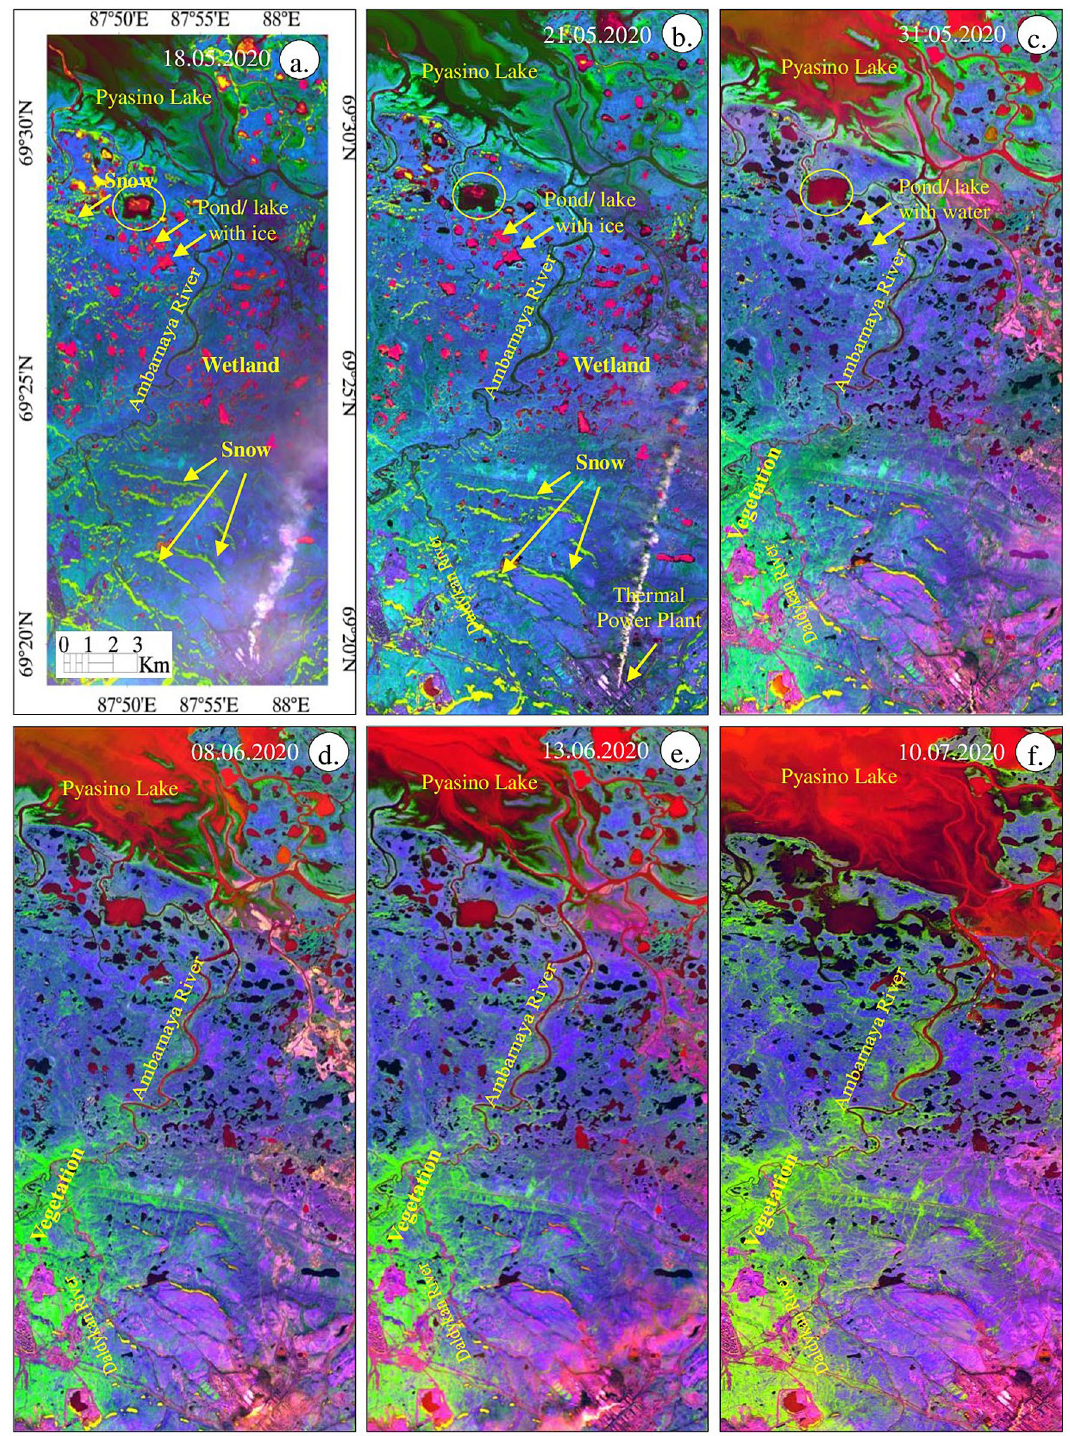
Figure 11. ( a – f ) Sentinel-2 decorrelated images of the spectral bands 3, 8, and 11 of the May 18 to July 10, 2020 [ENVI 5.5 https ://www.harri sgeos patia l.com; https ://senti nel.esa.int/] showing the presence of snow, water, vegetation, and wetland